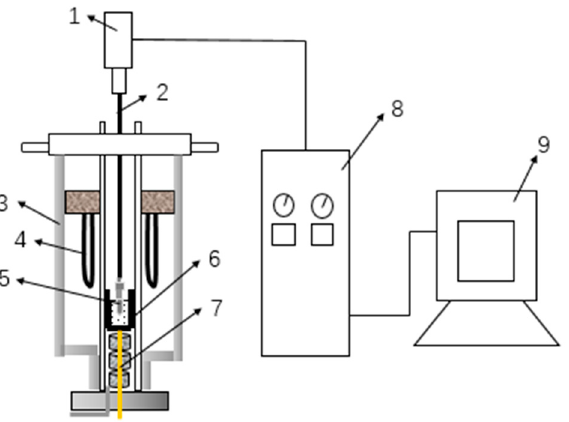
Figure 1. Schematic diagram of the viscosity measuring device. 1—Torque transducer; 2—corun- cible; 7—thermocouple; 8—control cabinet and